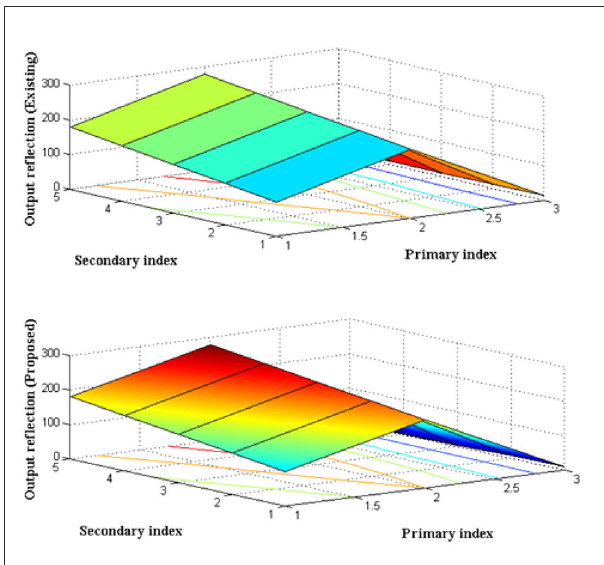
FIGURE3 Reflection index with primary and secondary focus.